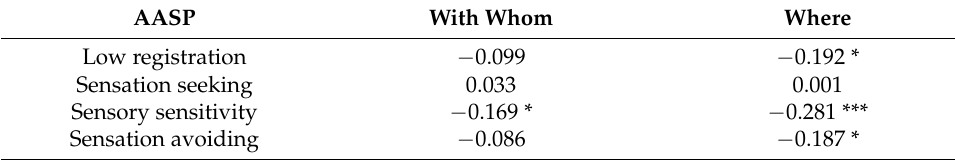
Table 3. Correlation matrix between AASP Scores and CAPE With whom and Where.